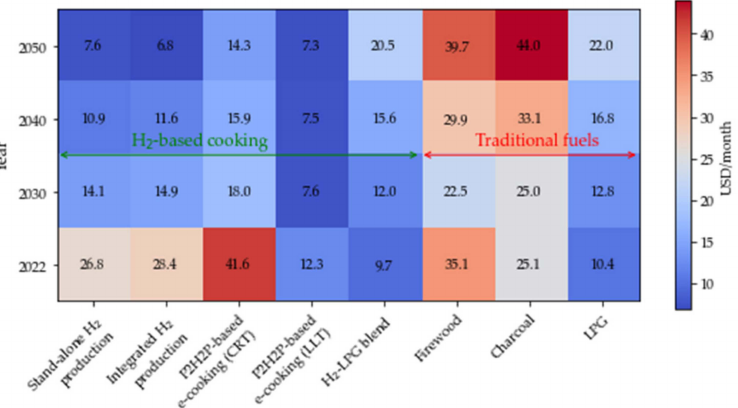
Figure 3. Monthly household costs of cooking (including fuel costs and stove financing). CRT = cost- reflective tariff (average privately owned mini-grid tariff); LLT = lifeline